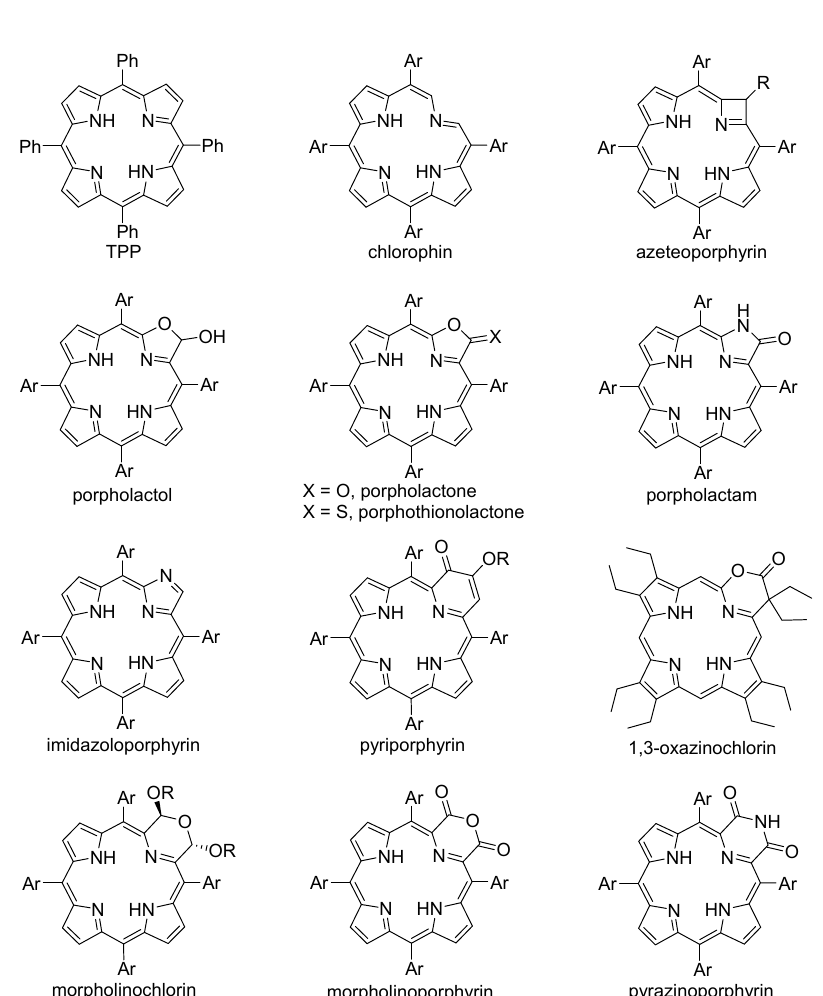
Figure 1. meso -Tetraphenylporphyrin (TPP) (for comparison) and examples of pyrrole-modified porphyrins discussed in this review.